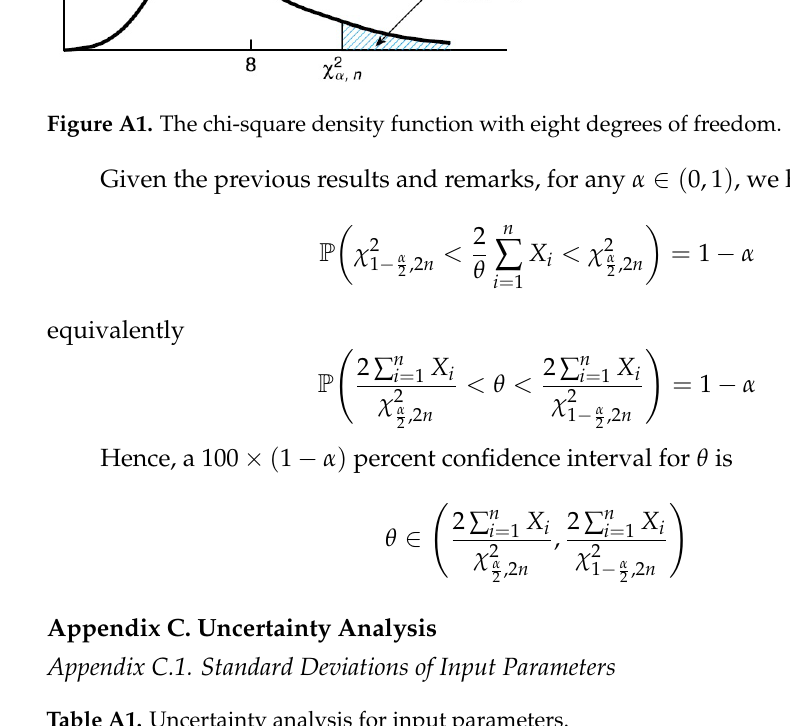
Table A1. Uncertainty analysis for input